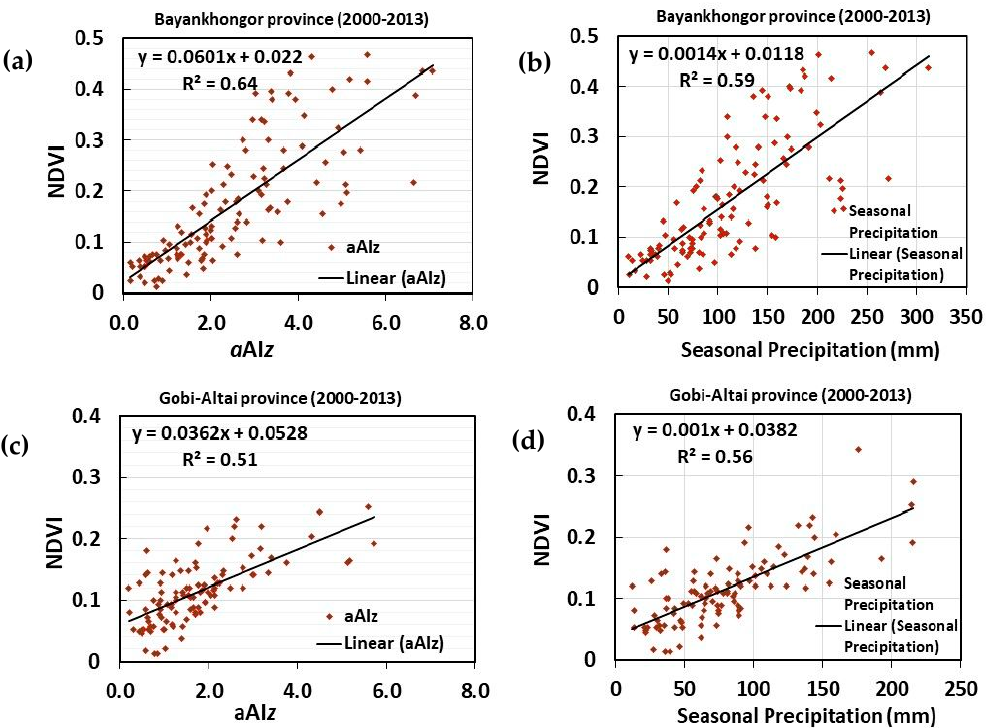
Figure 6. Scatter plot showing the mean August correlation values between NDVI and aridity index ( a AI z ); seasonal precipitation (mm) in ( a , b ) Bayankhongor and ( c , d ) Gobi-Altai.